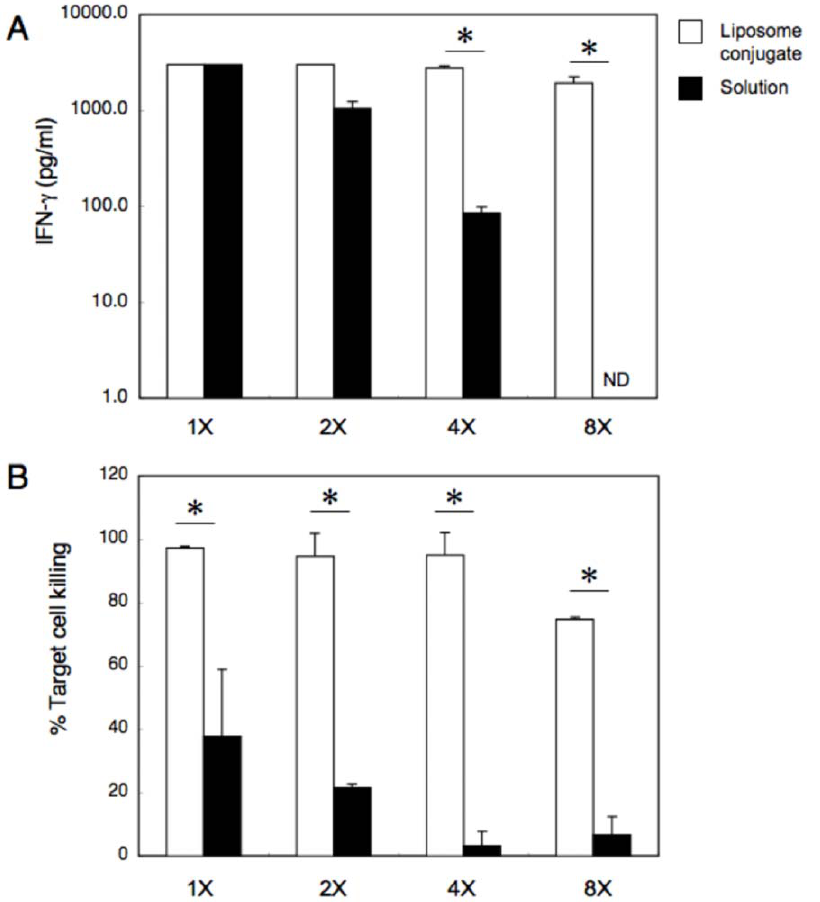
Figure 2. Dose-response of cytokine production by CD8 + T cell and CTL induction in mice immunized with OVA 257-264 -liposome or with OVA 257-264 solution. A serial two-fold dilution of OVA 257-264 -liposome (open box) and OVA 257-264 solution (closed box) were made in PBS, and mice were immunized with the diluents in the presence of 5 m g CpG. OVA 257-264 solution containing equal amounts of peptides as those in OVA 257- + T cells ( A ) and the CTL response ( B ) were monitored as described in 264 -liposome. One week after the immunization, IFN- c production by CD8 Materials and Methods. Data represent means and SE of three mice per group. *, significant difference (p .